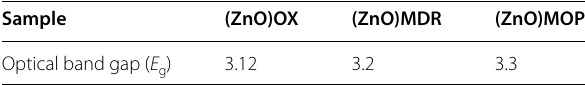
Table 2 Optical band gap of zinc oxide nanoparticles obtained using different preparation methods